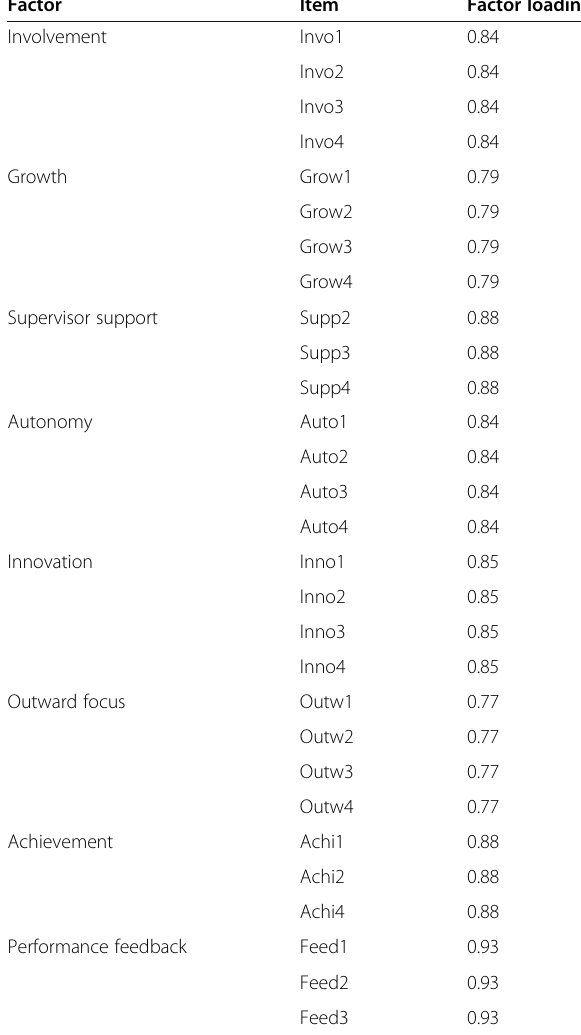
Table 5 Mixture Model Clustering (MMC) class